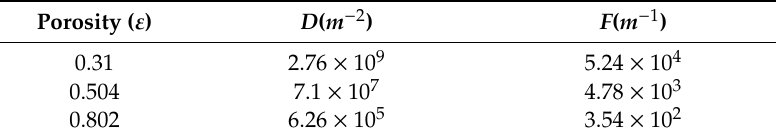
Table 3. Darcy and Forchheimer coe ffi cients for di ff erent porosities.